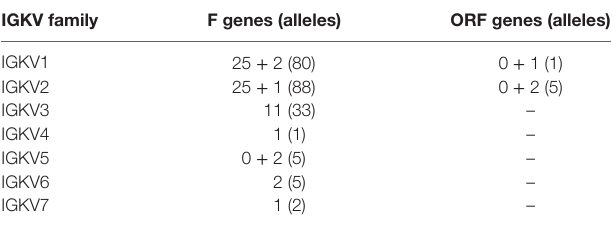
(Table S6A in Supplementary Material, Figure 5 ). The IGKV allele library contains a total of 70 functional genes